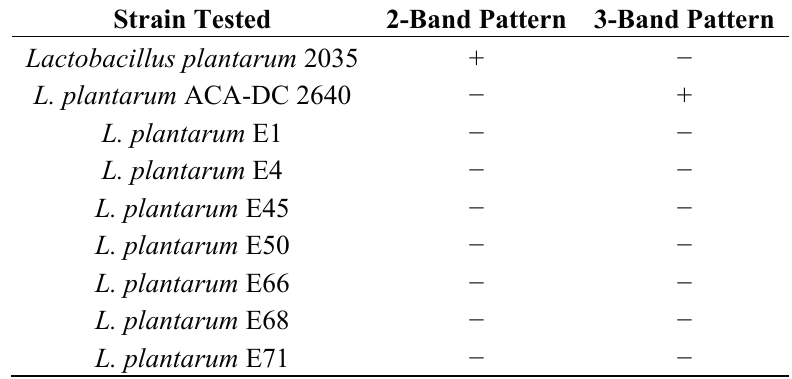
Table 2. The complete list of Lactobacillus strains tested in multiplex PCR with the RAPD-derived primer pair p30R/p30F for L. plantarum 2035 and primer pairs p29AR/p29F and p29BR/p29F for L. plantarum ACA-DC 2640, respectively. A unique 2-band pattern is only produced for L. plantarum 2035 and a unique 3-band pattern is only produced for L. plantarum ACA-DC 2640 (indicated as